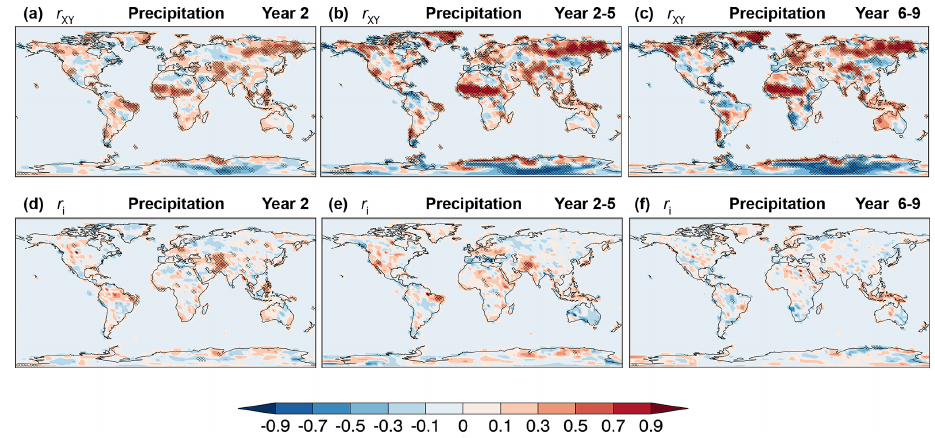
Figure 13. Skill of CanESM5 annual and multi-year mean precipitation hindcasts. (a–c) Correlation skill r XY , Eq. (6), and (d–f) contribution from initialization r i to correlation skill, Eq. (A17), for forecast (a, d) Year 2, (b, e) Year 2–5, and (c, f) Year 6–9. The verifying observations are from the GPCP2.3 data set (Appendix B). Cross-hatched regions indicate values significantly different from zero at the 90% confidence level.